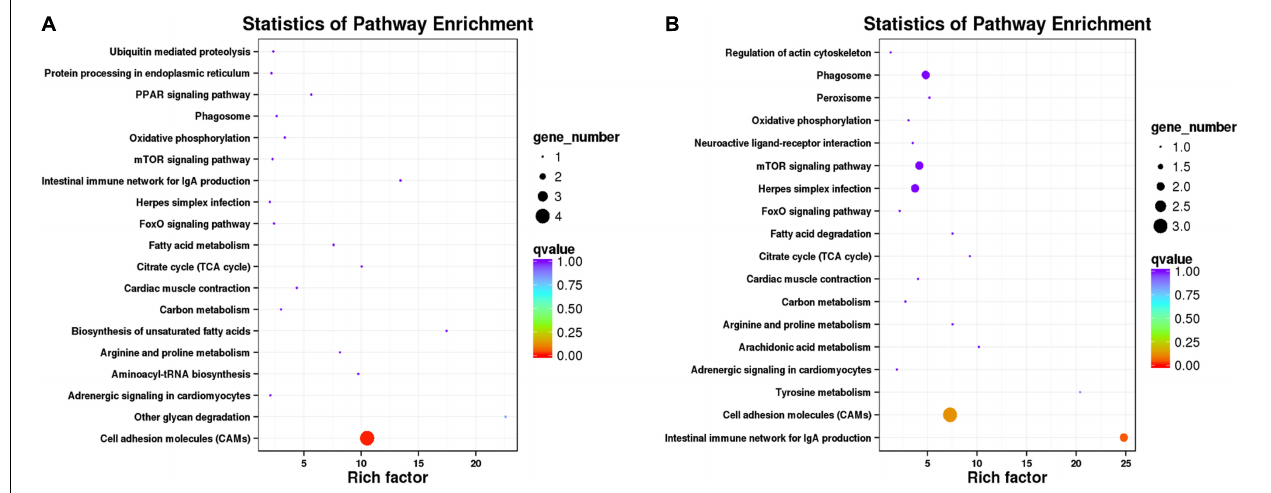
FIGURE 5 | Pathway enrichment analysis of DEGs in bone tissues of bighead carp. (A) Enriched pathways from frontal and parietal bones between big and small groups of bighead carp. (B) Enriched pathways from vertebral bones between big and small groups of bighead